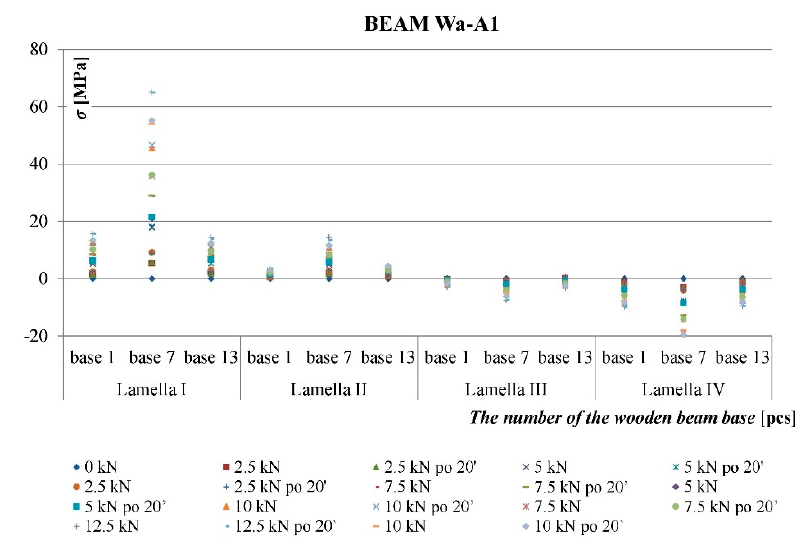
Figure 8. Distribution of normal stresses in the wood σ [MPa] along the entire length of the Wa-A1 reinforced beam.